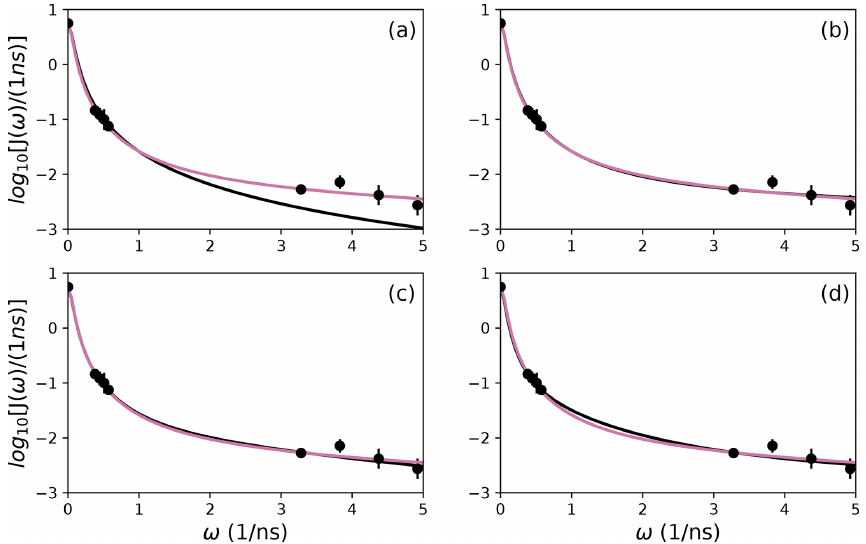
Figure 10. Comparison of individual fits for Arg 26 of (a) Model 1, (b) Model 3, (c) Model 4, and (d) Model 5 (black lines) or the bootstrap aggregation smoothed fit (reddish-purple line) to (circles) experimental spectral density